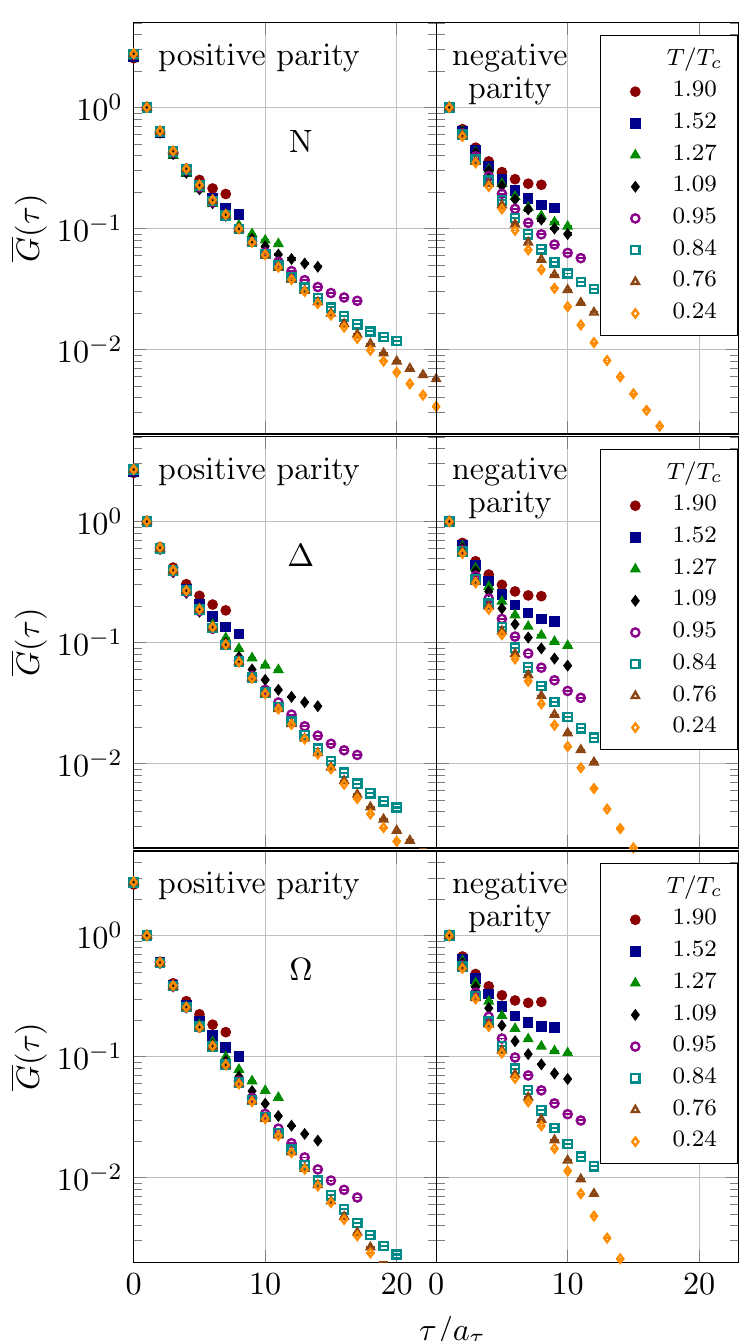
Figure 1 . Correlators G ( (cid:28) ) for the positive- and negative-parity channels at di(cid:11)erent temperatures, in the N , (cid:1) and (cid:10) sectors, on a logarithmic scale